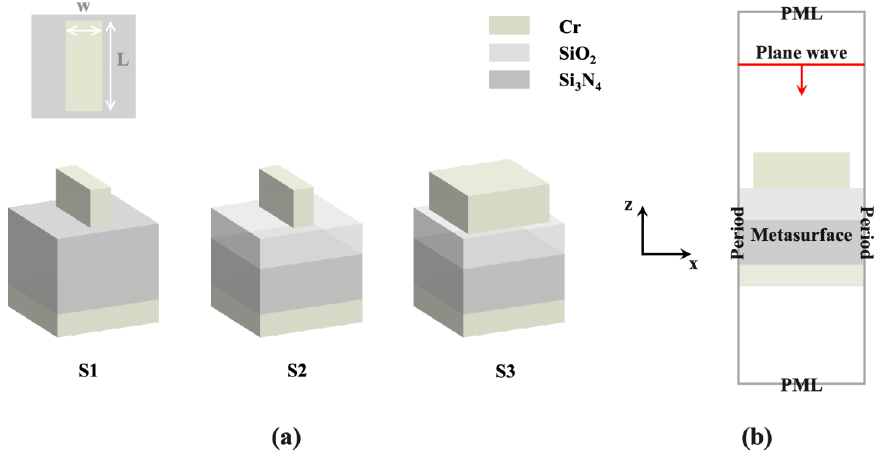
Figure 1. ( a ) Design process of metasurfaces involving three structures of S1, S2, and S3. ( b ) Schematic of boundary condition settings in simulation.